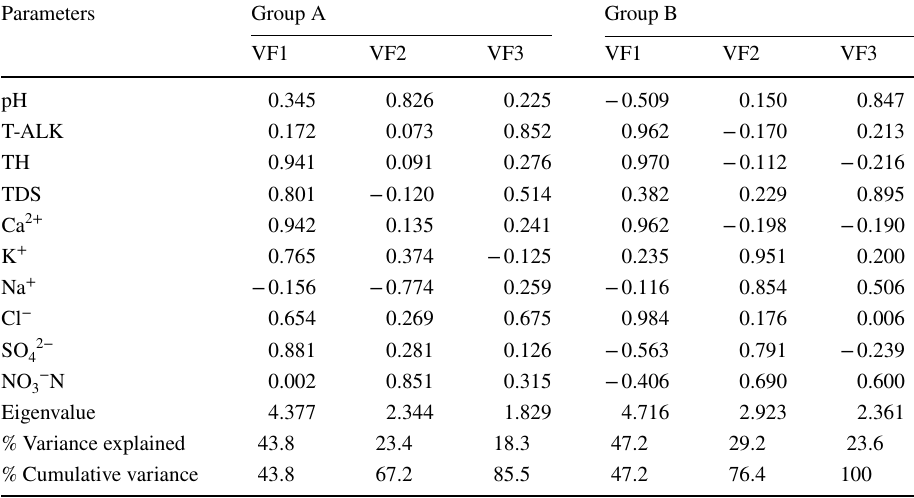
Table 4 PCA results summarized the rotated component matrix of standardized water quality data and the eigenvalues of each